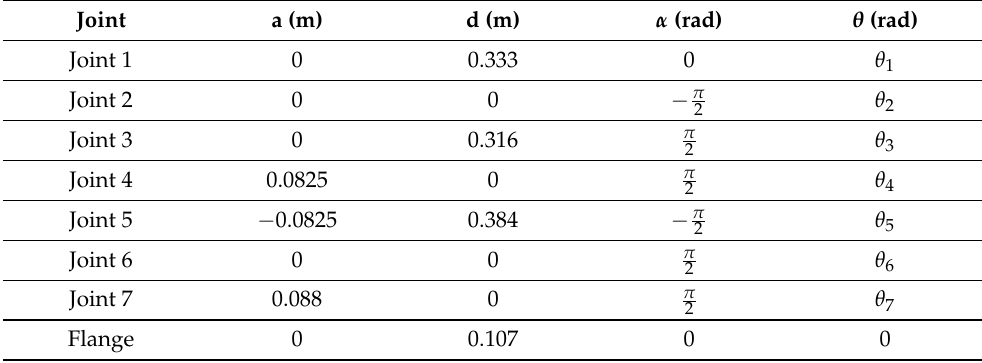
Table 1. The table of the Denavit–Hartenberg parameters for PANDA derived following Craig’s convention, further information on the PANDA can be accessed from the cited link